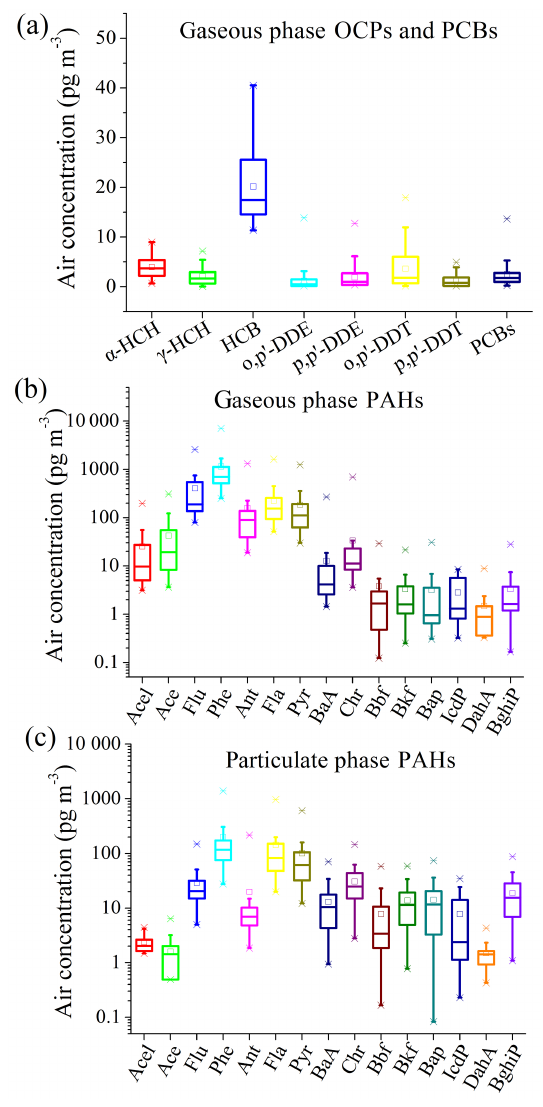
Figure 2. Air concentrations of gaseous OCPs and PCBs (a) , gaseous PAHs (b) , and particulate-phase PAHs (c) in Nam Co. The boxes are defined by the 25th and 75th percentiles, whiskers mark the 10th and 90th percentiles, the median is represented by a hori- zontal line, the mean by a square, and outliers with an